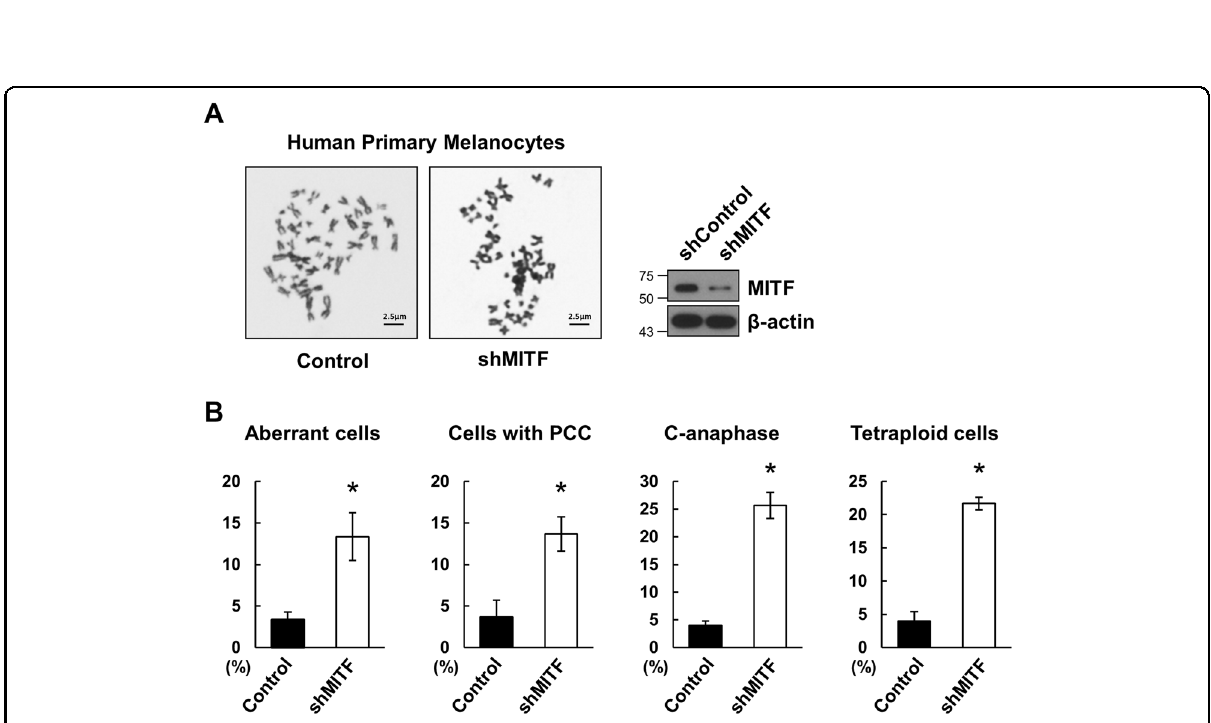
Fig. 3 Mitf functions in chromosome stability after UVR. A Metaphase spread was performed in HPMs with or without Mitf silencing as indicated. Representative images are displayed. B Graphs illustrating the percentage of cytogenetic abnormalities in metaphase spread in A from three independent experiments. n = 50, error bars represent